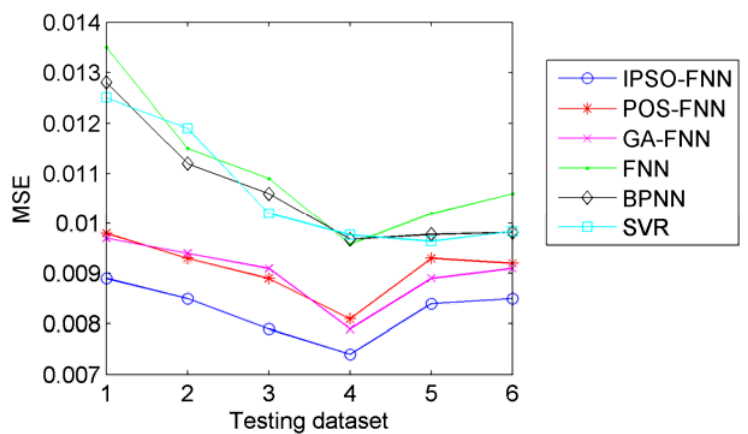
Figure 4. Comparison of mean square error.